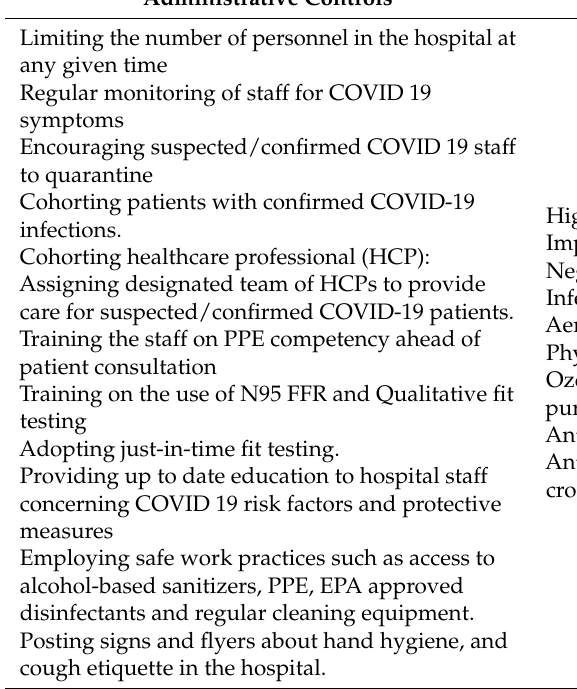
Table 3. Consolidated review of administrative, engineering controls, and PPE guidelines recommended by the Occupational Health and Safety Administration and the Centers for Disease Control (OSHA and CDC, respectively). Administrative Controls Engineering